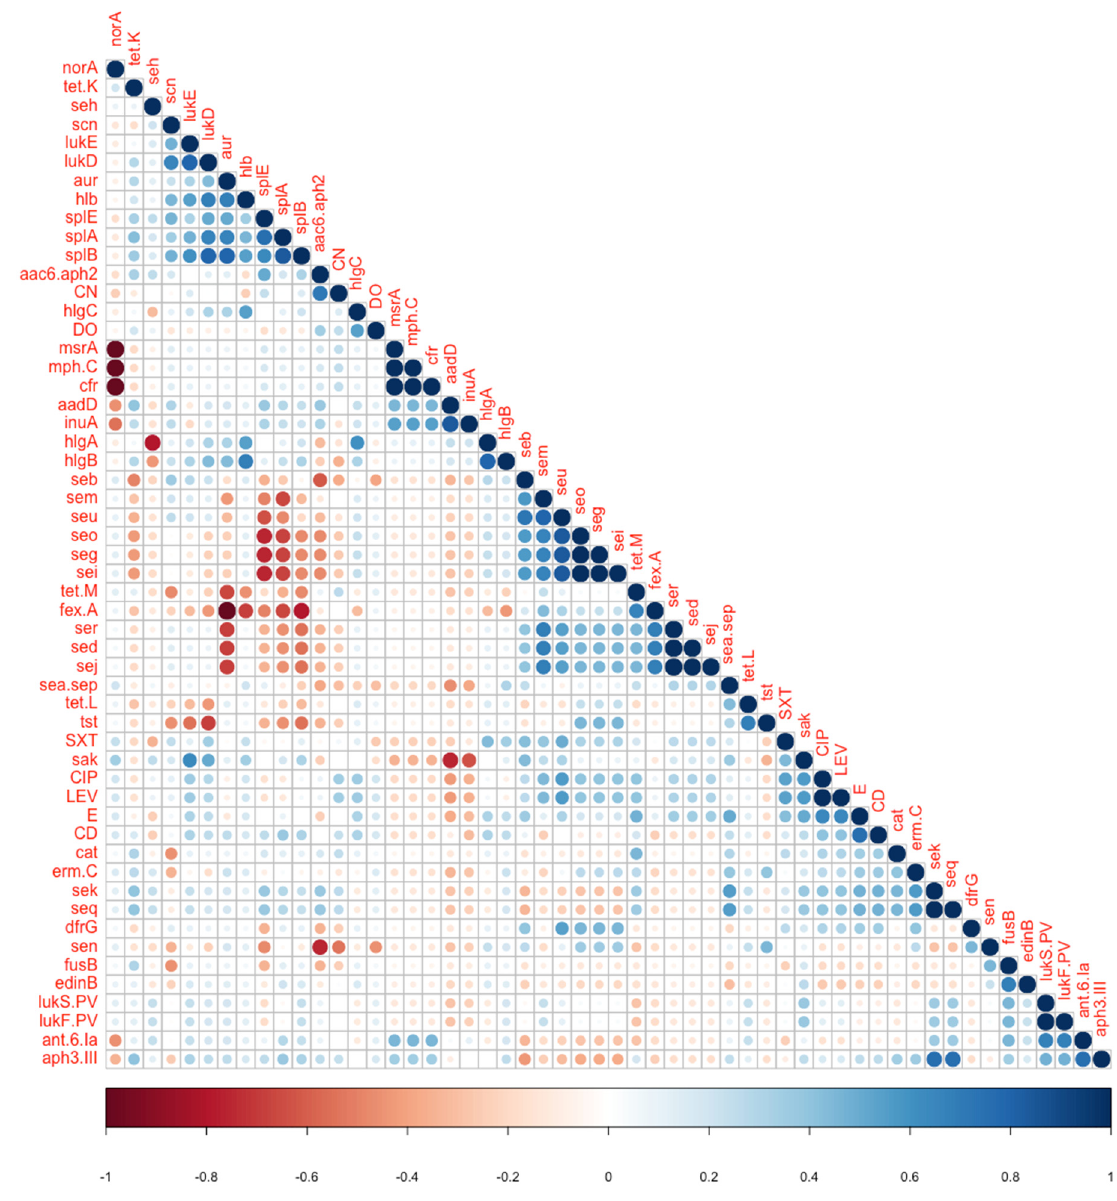
Figure 3. Correlation matrix indicating all correlations between pairs of genetic or phenotypic determinants (resistance phenotypes). Shades of blue represent positive correlations, while shades of orange/red represent negative correlations. Similar analyses were conducted separately among resistance-related pairs of traits and virulence-related ones (Supplementary Figure S1).